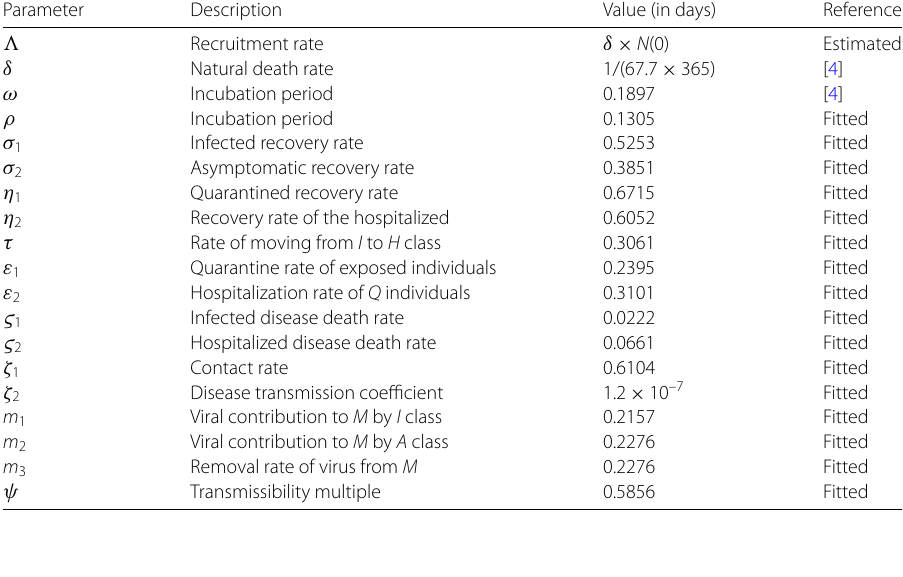
Table 1 Description of the model parameters and their estimated and fitted values Parameter Description